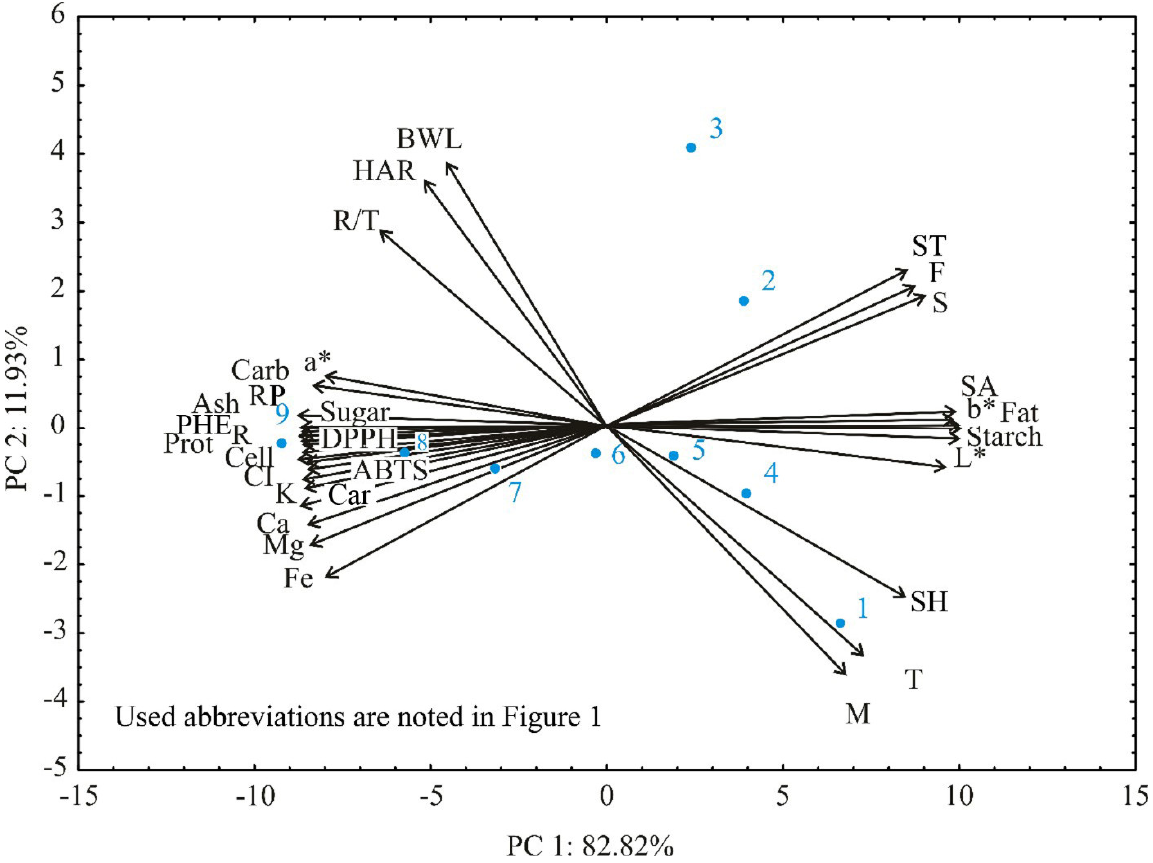
Figure 2. PCA of tested cookies with and without the addition of L and OL